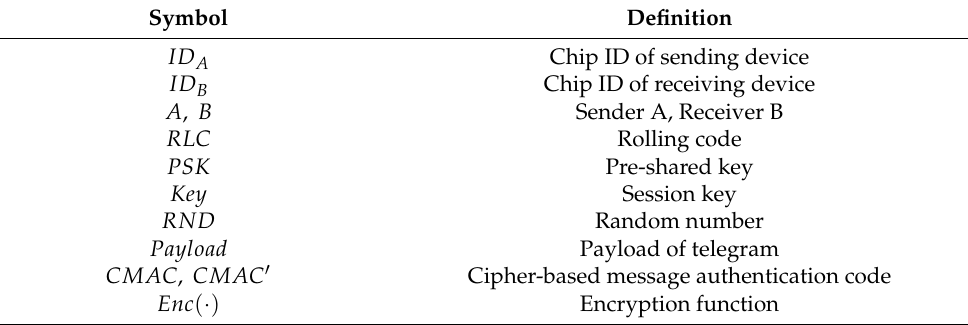
Table 2. Symbolic representation of EnOcean communication